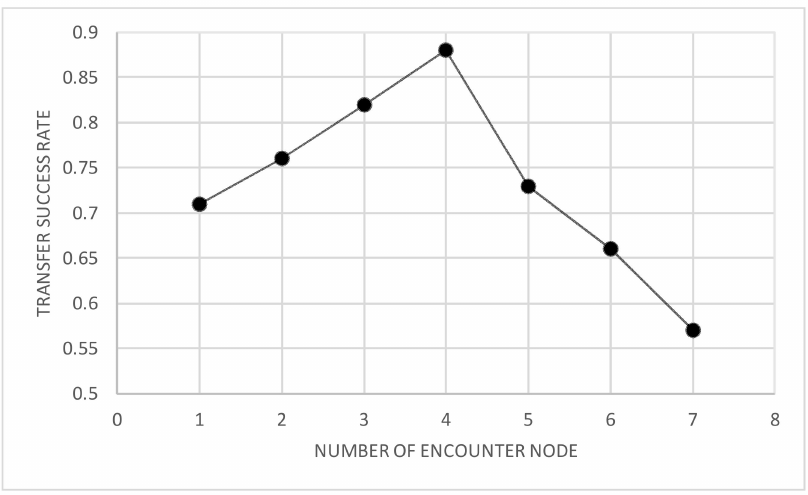
Figure 5. The relationship between transfer success rate and number of encounter